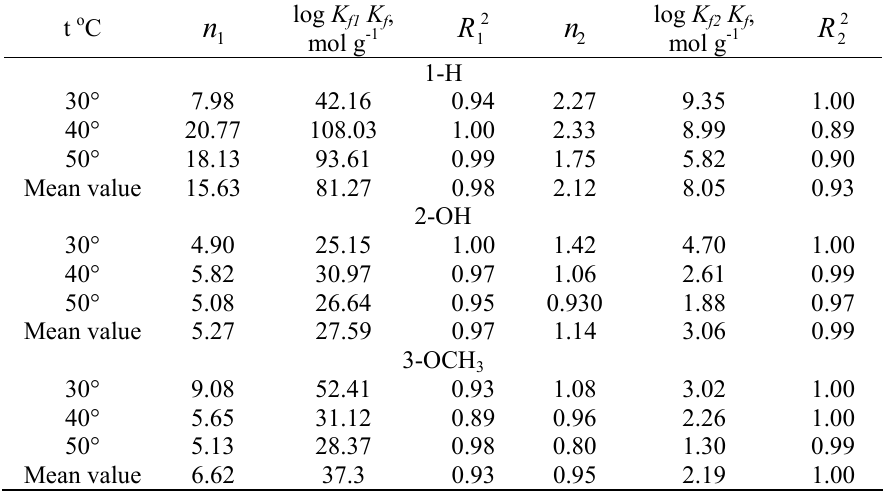
Table 5. FAIM parameters and correlation coefficients at different